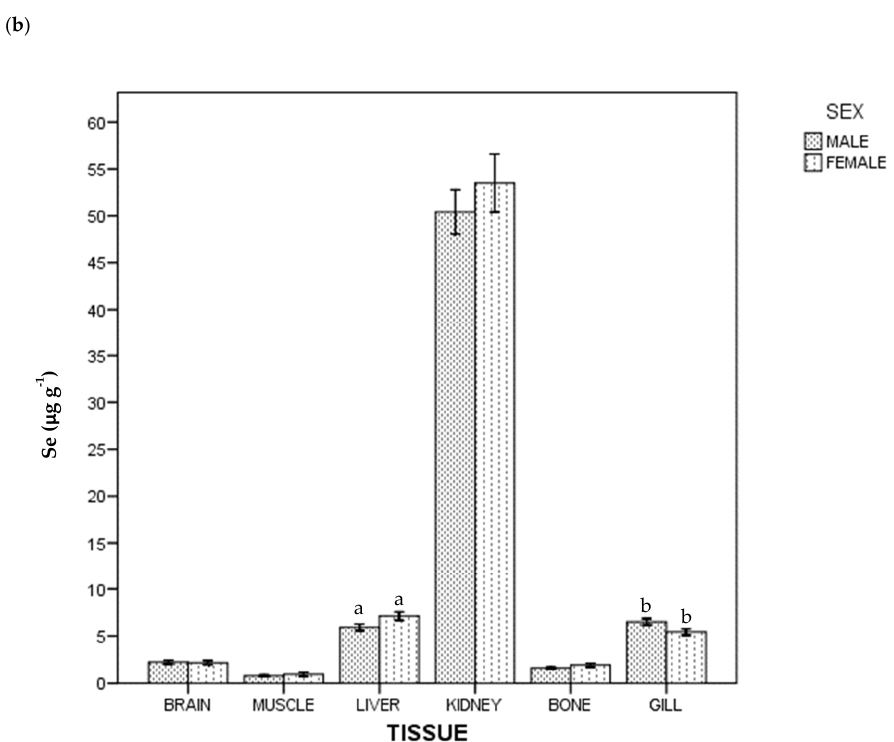
Figure 1. Total Hg ( a ) and Se ( b ) concentrations of ABFT by tissue and sex. For each tissue, the same lowercase letter shows statistical differences between males and females. Bars show standard error. For each tissue, "the same lowercase letter (a, b, c and d in Figure 1a; a and b in Figure 1b) shows statistical differences between males and females”. For example, for liver, “a” is the same lowercase in male and female, so there is statistical differences between them. Int. J. Environ. Res. Public Health 2021 , 18 , x FOR PEER REVIEW Regarding the whole population, no differences in Se/THg concentration ratio be- tween gill, kidney, liver and brain were found, and these were higher than those found in bone and muscle ((gill~kidney~liver~brain) > bone > muscle). In males, differences be- tween kidney and gill were also found, and no differences between brain and bone in female were found. Differences between sexes are shown in Figure 2.